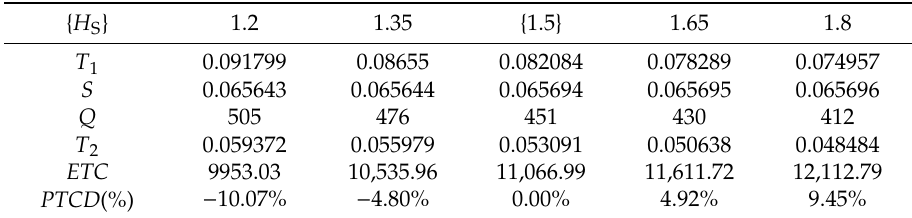
Table 13. Sensitivity analysis when the unit holding cost changes.